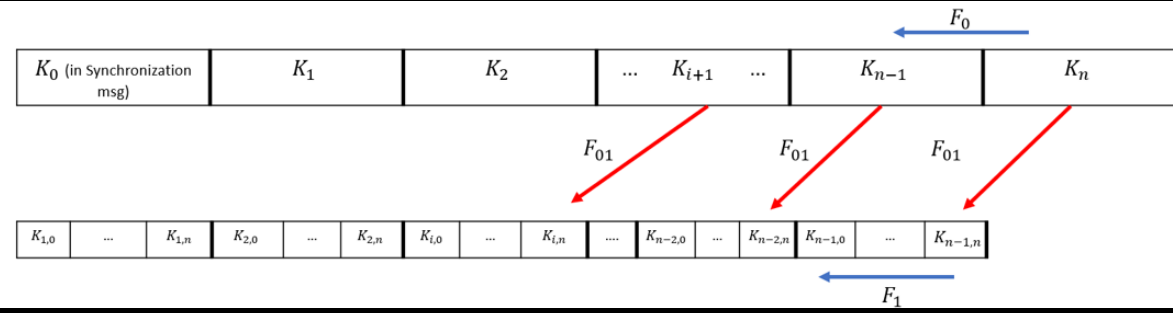
Figure 1. General Structure of Multilevel-µTESLA Protocol.